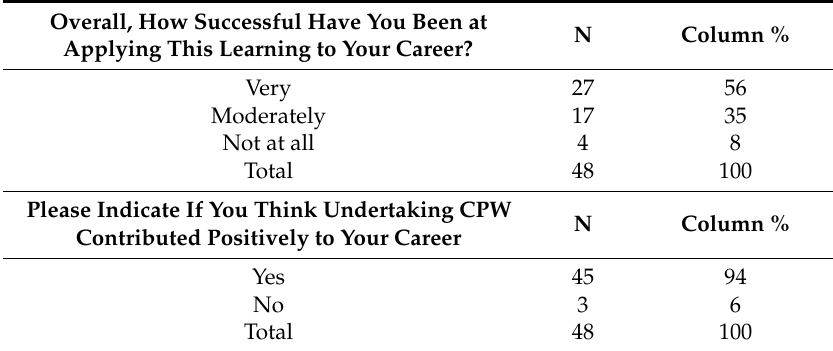
Table 3. Participants’ assessment of broader contributions of CPW to their